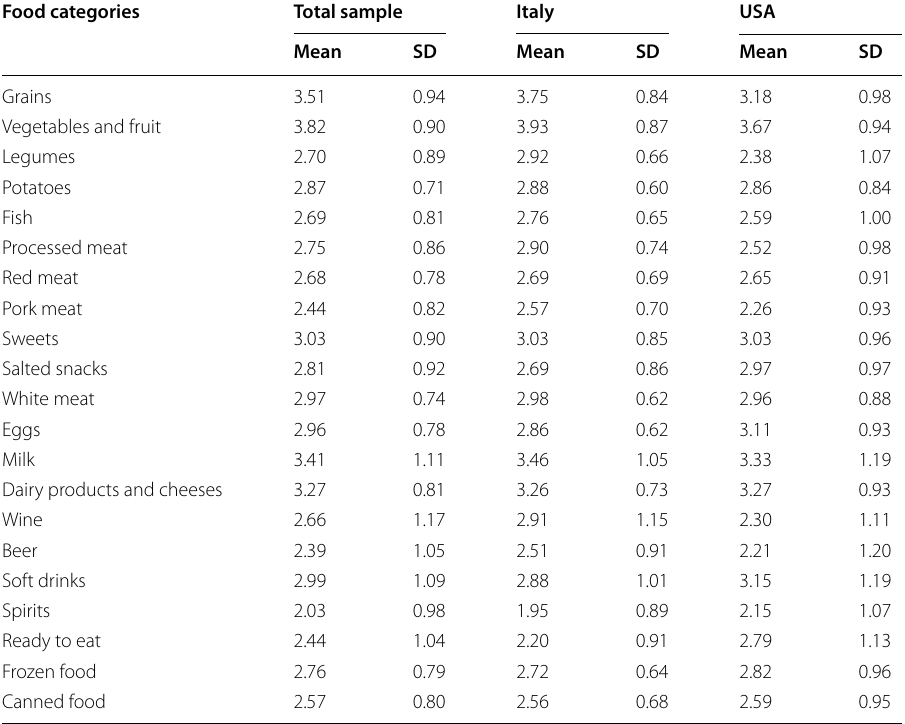
Table 2 Pre-COVID-19 average food consumption frequencies in Italy and the USA Food categories